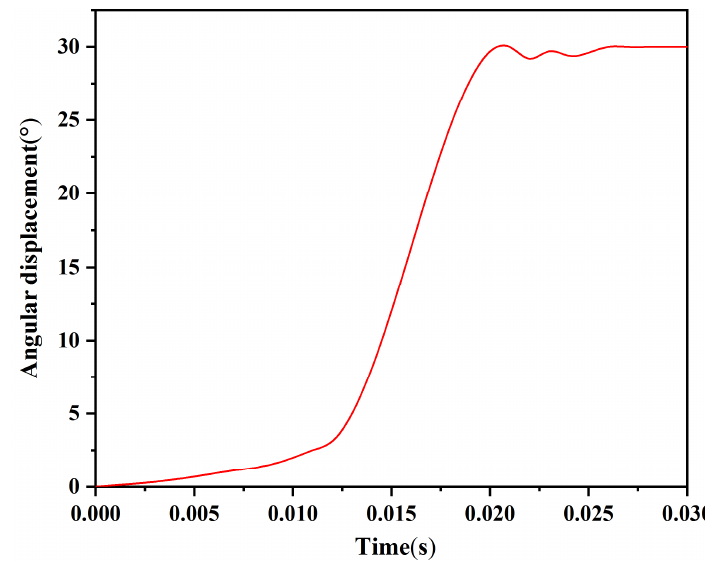
Figure 11. Time–angular displacement curve of the rotary pin.